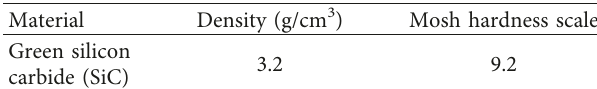
Table 5: Mechanical properties of green silicon carbide. Table 6: The experiment